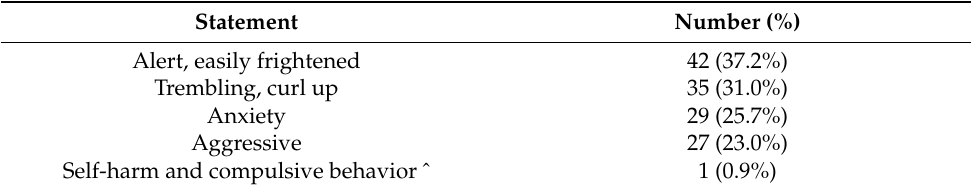
Table 12. Reasons for suspecting the case to be mental animal abuse. Multiple choices were allowed for this question. This was an open-ended question, and the respondents could add options them- selves. The results were calculated only from the answers of 113 veterinarians who claimed they had the knowledge to identify mental abuse, or who had encountered abuse cases.